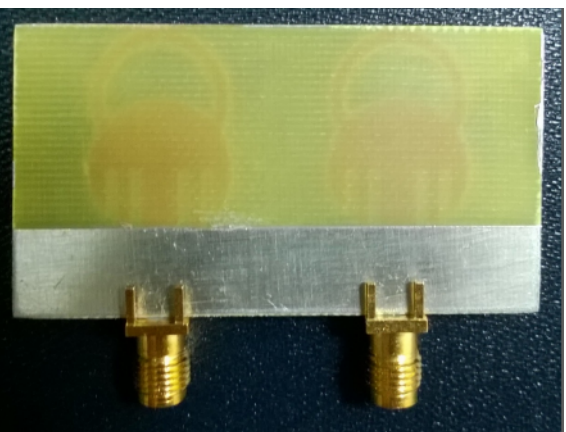
Figure 3 (b): Fabricated Antenna (Back